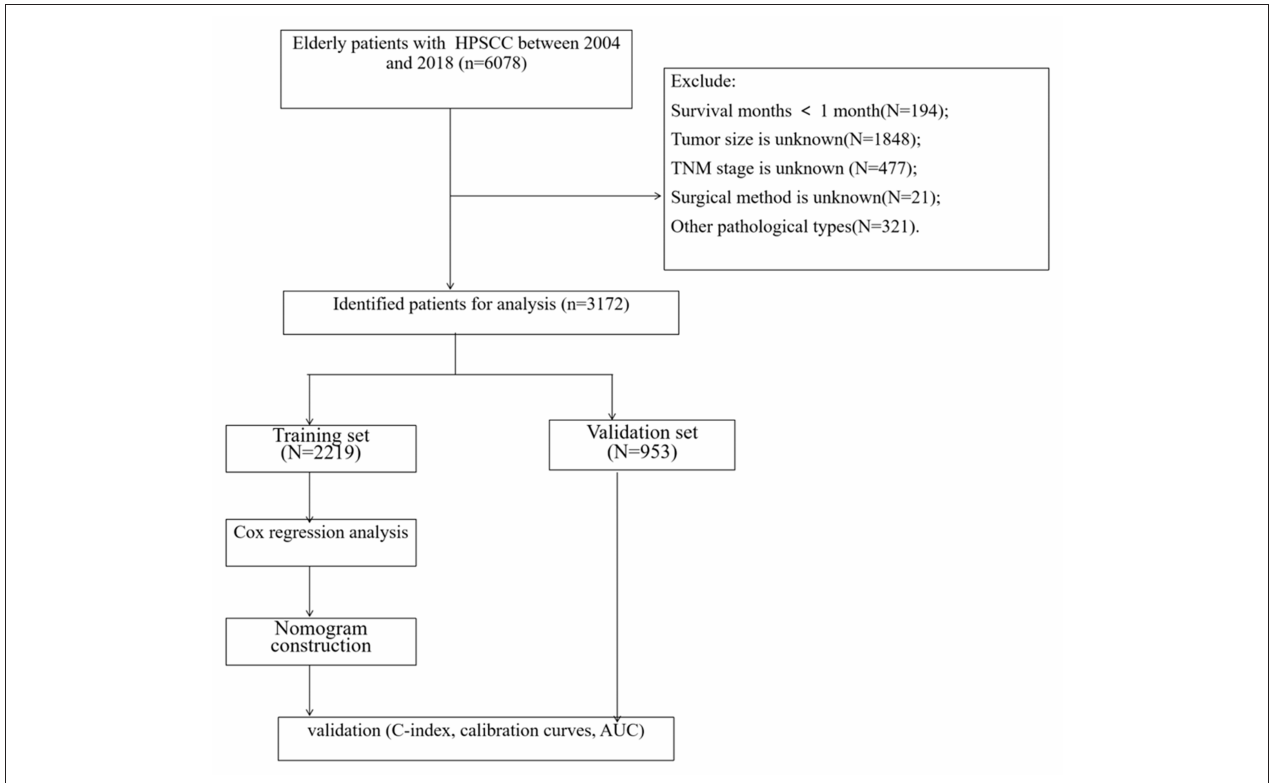
FIGURE 1 | The flowchart of including and dividing